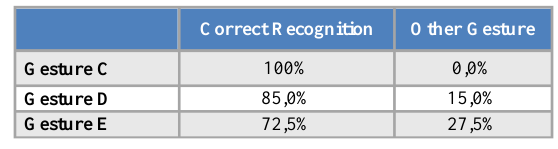
Table 2. Success rate for the recognition of